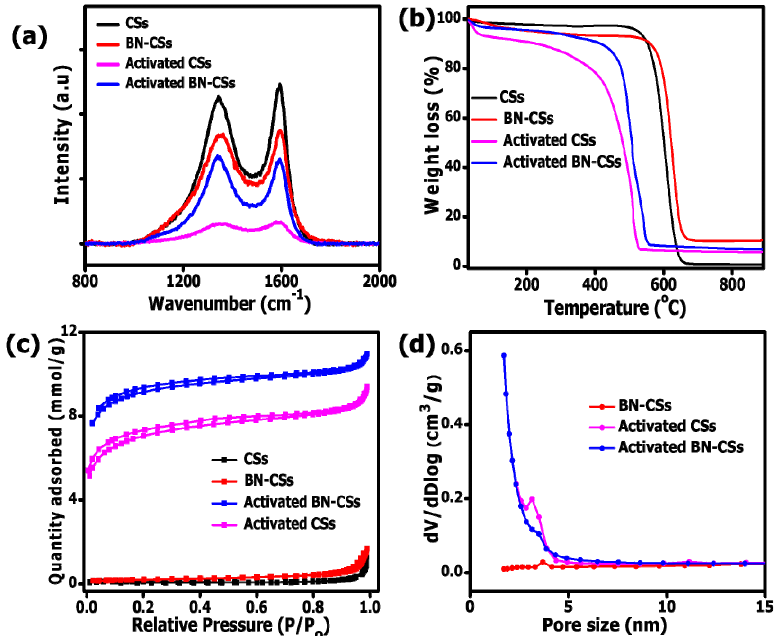
Figure 2. ( a ) Raman spectra, ( b ) thermogravimetric curves, ( c ) N 2 -adsorption-desorption isotherms and ( d ) pore-size distribution plots of the pristine and activated CSs and BN-CSs.